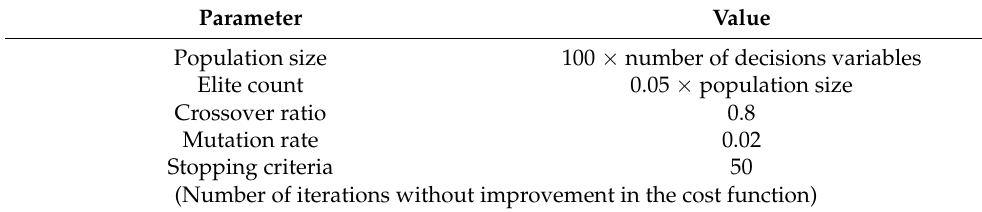
Table 1. Overview of the important parameters of the GA and their